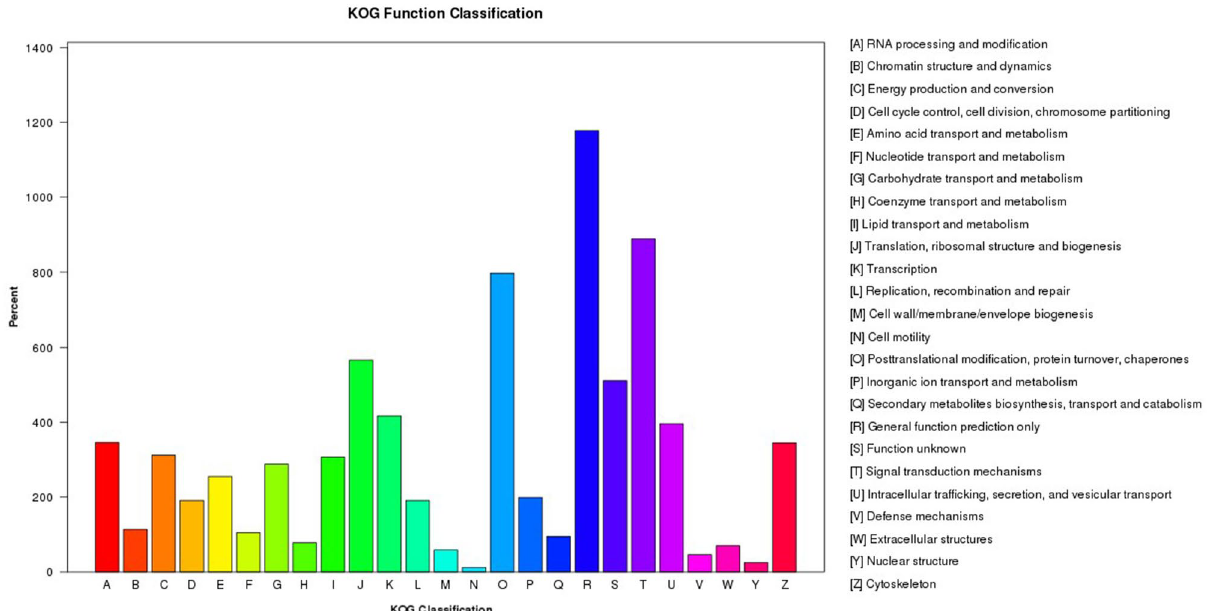
Figure 2. Distribution of All-unigenes according to the KOG functional classification. KOG EuKaryotic Orthologous Groups.